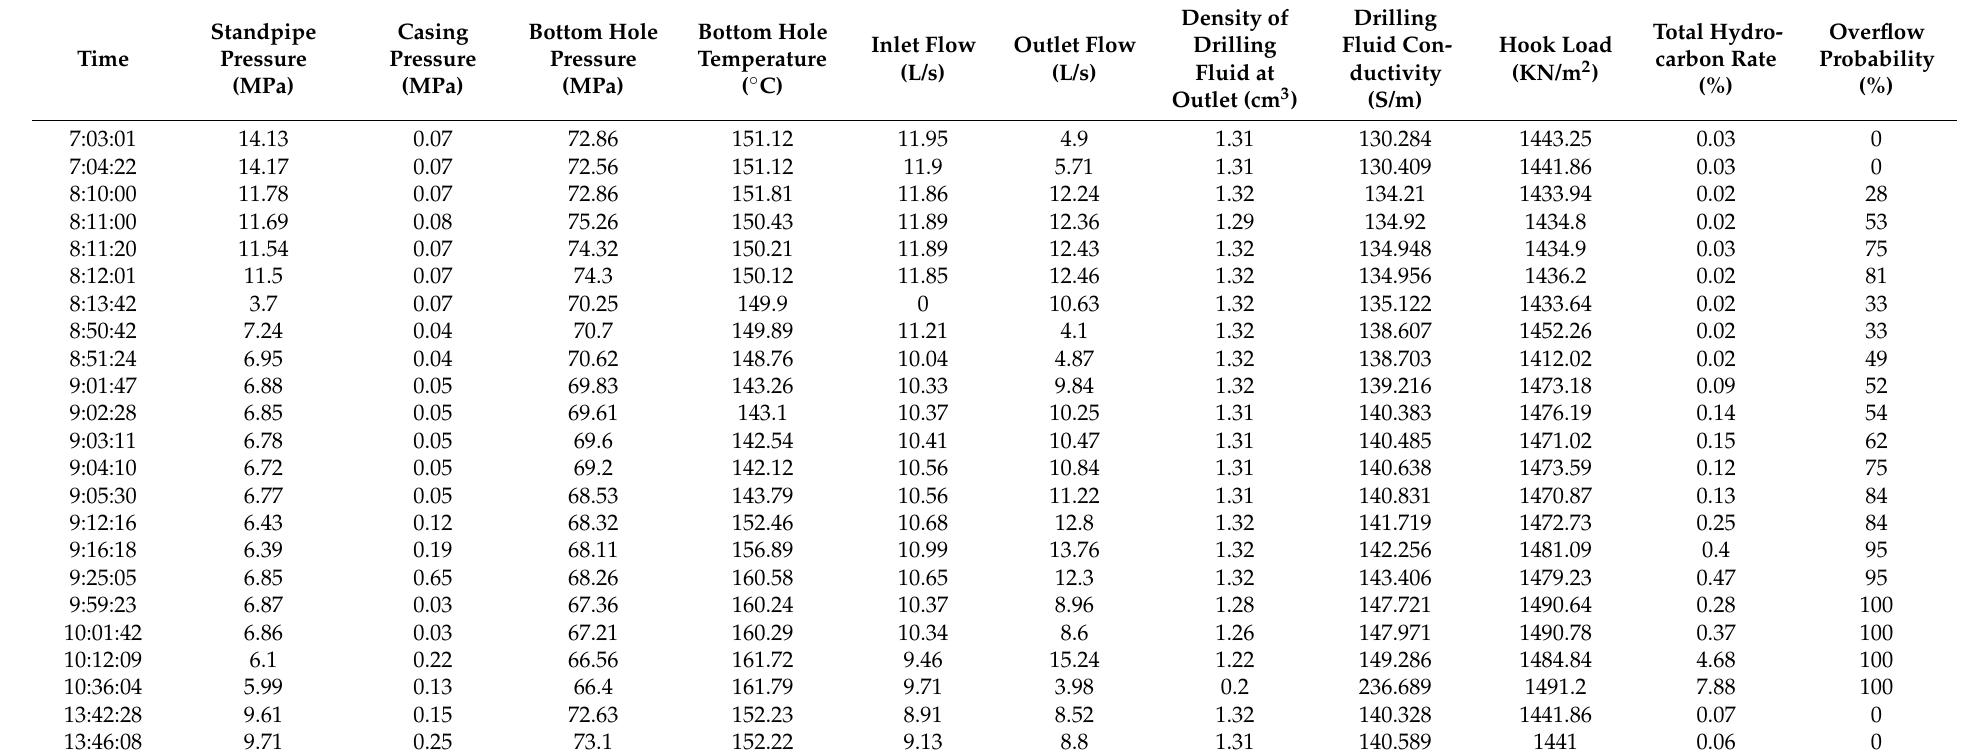
Table 5. Output results of overflow